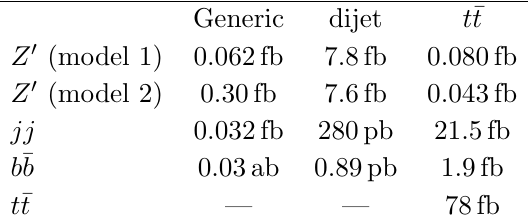
Table 5 . Signal and background cross sections for the Z 0 signal in scenario 3 and main SM backgrounds (in rows) under the three di(cid:11)erent event selections for generic, dijet, and t (cid:22) t resonance searches. The event selection is the same as in scenario 2, and the quoted backgrounds are the same as in table 4. The signal in the t (cid:22) t selection is also the